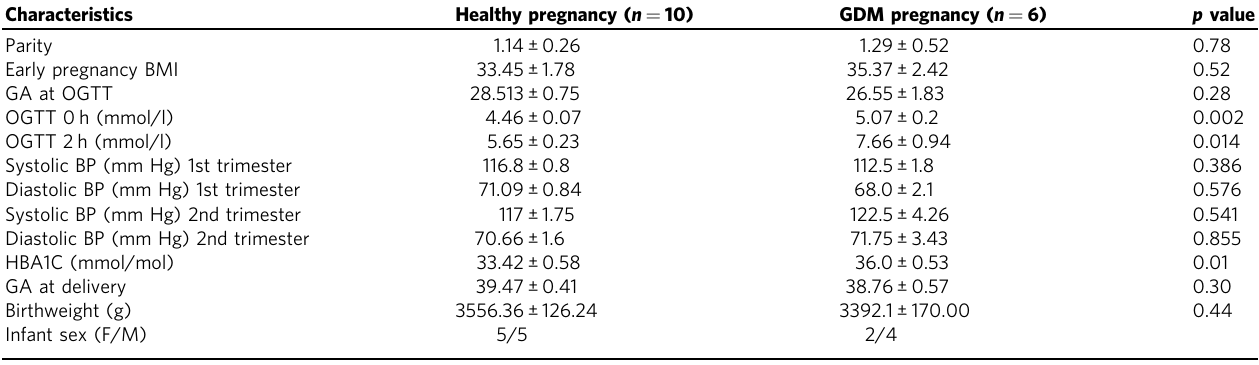
Table 1 Clinical characteristics of women used for the analysis of circulating placental hormone abundance in human pregnancy.